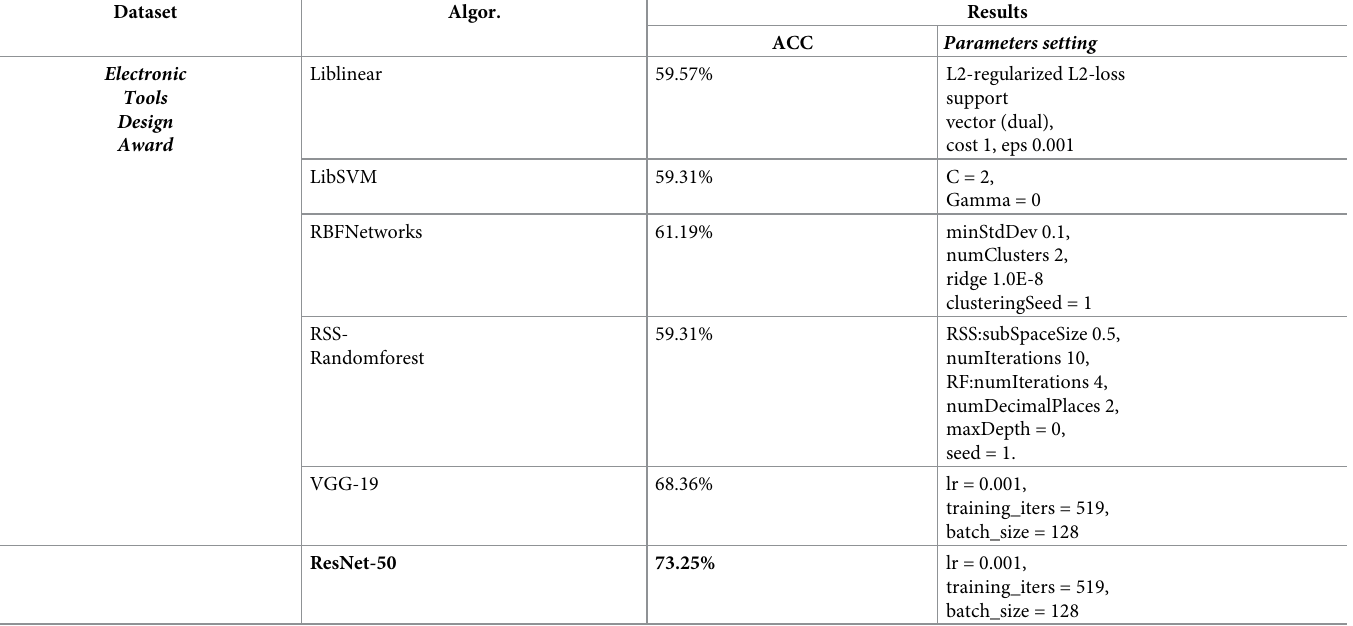
Table 6. Aesthetic-aware modeling verification in the Electronic Tools Design Awards design award dataset.